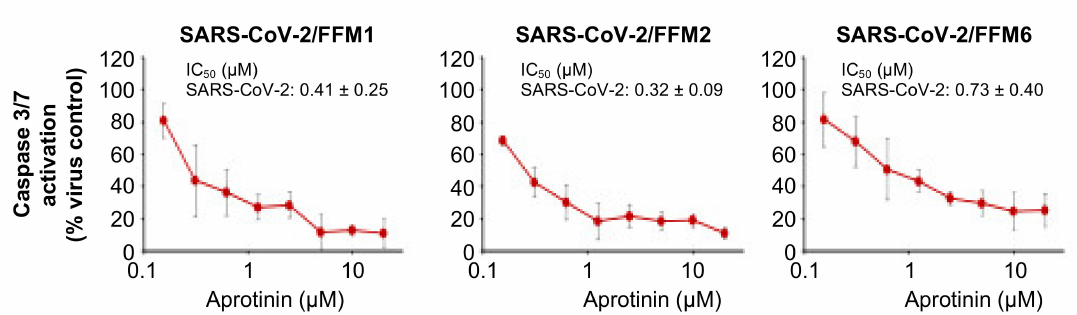
Figure 2. E ff ects of aprotinin on SARS-CoV-2-induced caspase 3 / 7 activation. Caspase 3 / 7 activity was determined in Caco2 cells infected with di ff erent SARS-CoV-2 isolates (MOI of 0.01) 48 h post-infection.